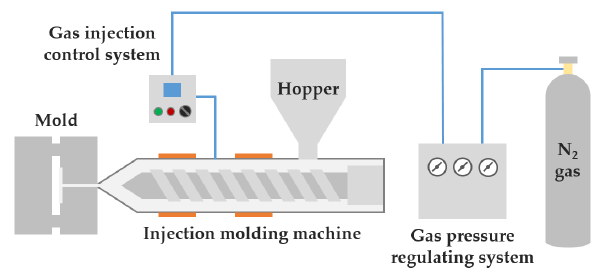
Figure 3. Schematic diagram of the microcellular foam injection molding process.